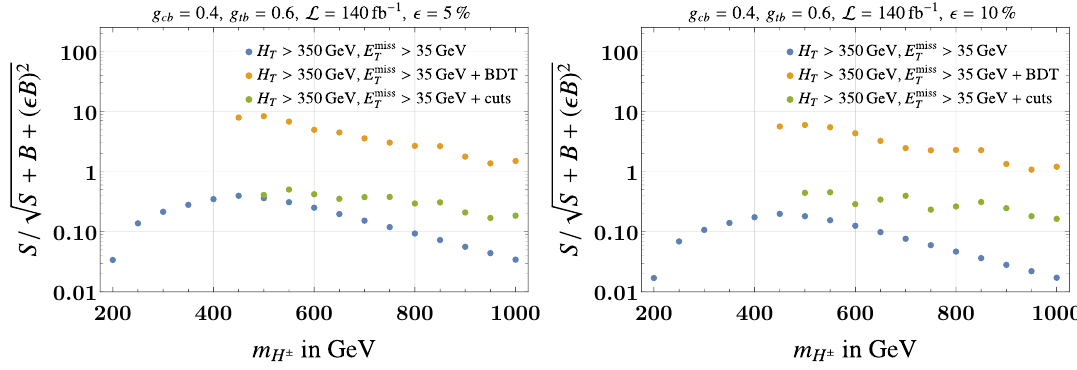
Figure 11 . Significance Z as a function of the charged Higgs mass for various cuts. Shown are results for a systematic error of (cid:15) = 5% (left panel) and (cid:15) = 10% (right panel). Blue points correspond to the cuts of BP1 in ref. [48], green ones to additional cuts on p correspond to optimised cuts using a boosted-decision-tree algorithm